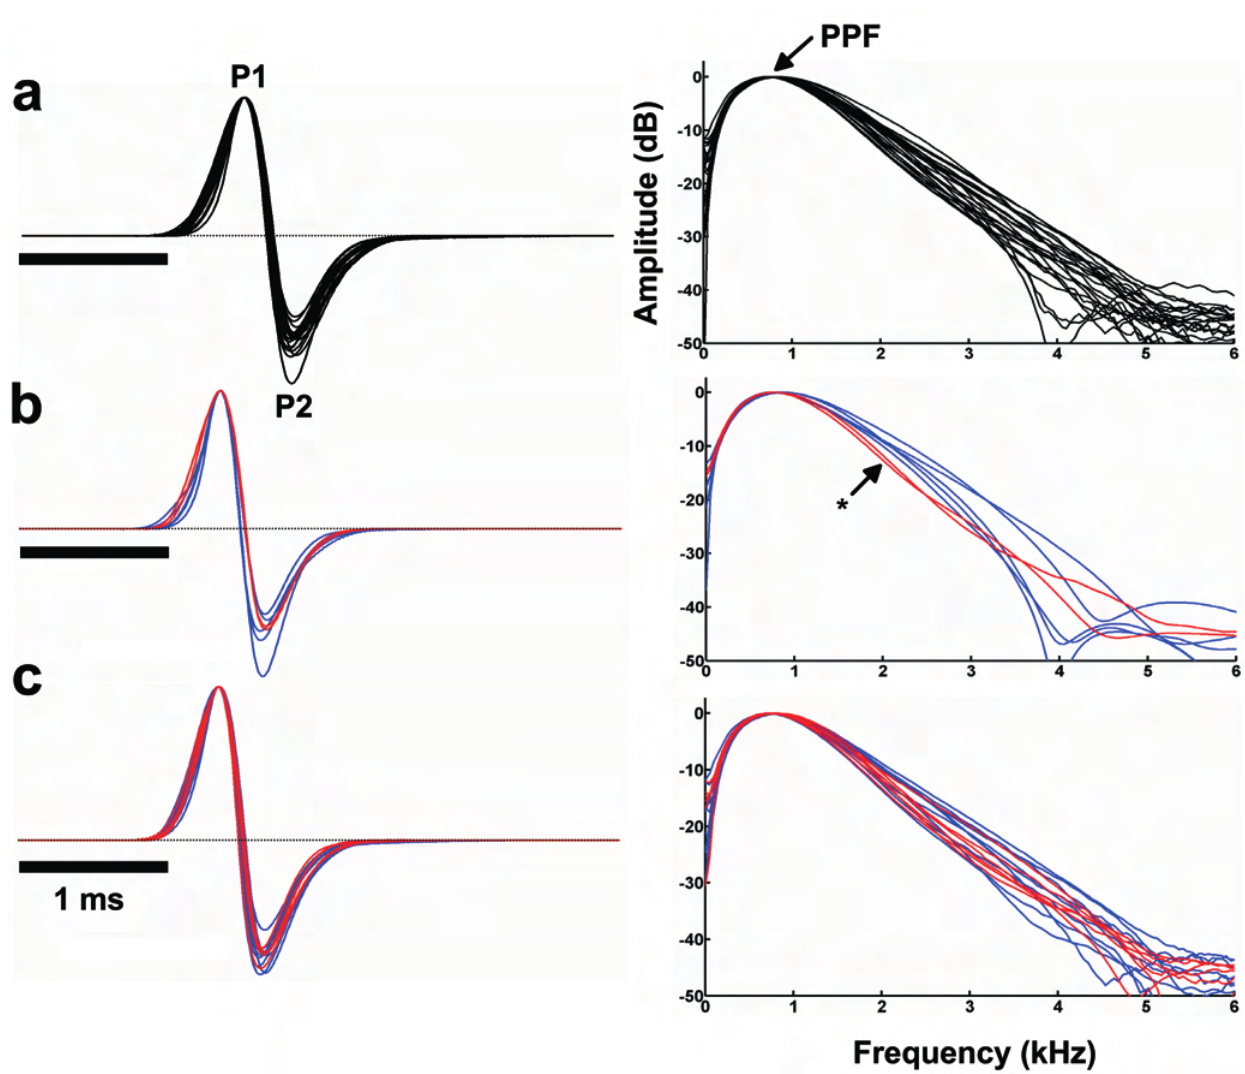
Fig. 4. Electric Organ Discharge (EOD) waveform (left) and Spectral Power Density (right) of adult specimens of Brachyhypopomus draco from Rio Grande do Sul state, Brazil. a: All 23 recorded specimens with developing or fully devel- oped gonads (86-135 mm). b: 7 adult specimens with fully mature gonads; 5 male (blue) 2 female (red). c: 16 adult specimens with developing gonads; 10 males (blue), 6 females (red). EODs plotted with head positivity upwards, normalized to the amplitude of the dominant positive phase (P1), and aligned at the P1 peak. Scale bar = 1 ms. Spectral Power Densities (SPDs) were computed from a 65, 536-point Fast Fourier Transform and the Peak Power Frequency (PPF) scaled to 0 dB. Upper and lower ranges of the PPF are marked with arrows. Note the more rapid decline of the SPDs of the two sexually mature females versus males (labeled with asterisk in c) but no obvious sexual difference in EOD waveform shape or